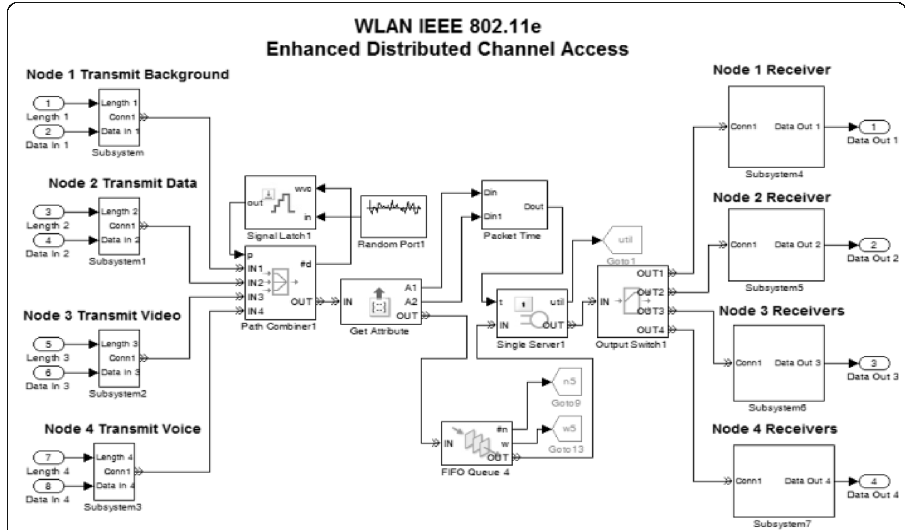
Fig. 5 MATLAB WLAN EDCA simulation